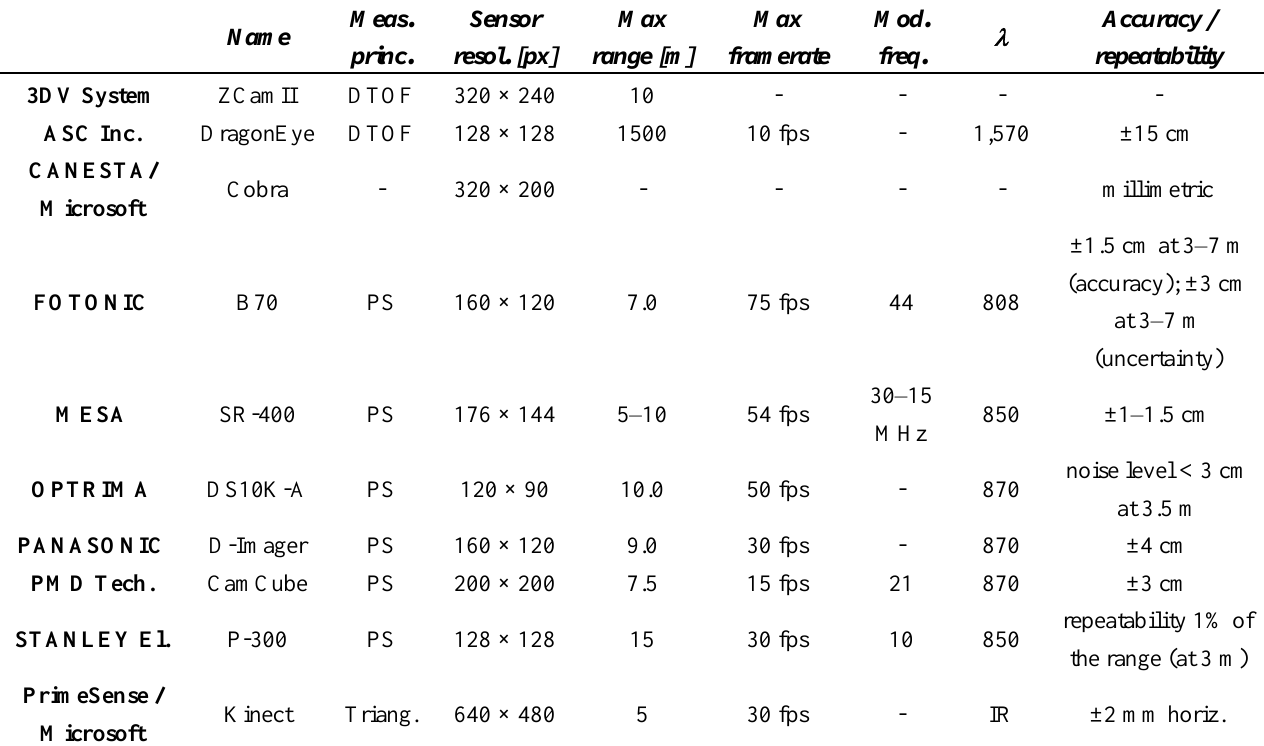
Table 9. Most common commercial Range Imaging (RIM) cameras (PS =